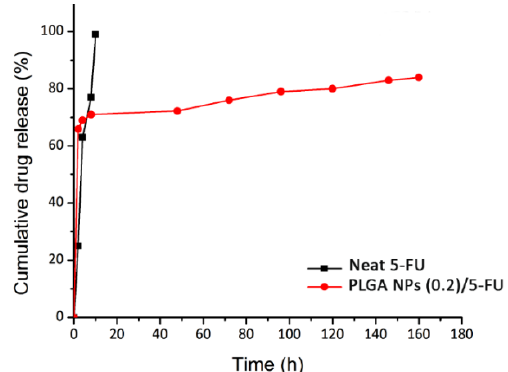
Figure 5. In vitro release profiles of neat 5-FU and PLGA NPs (0.2)/5-FU during 165 h.